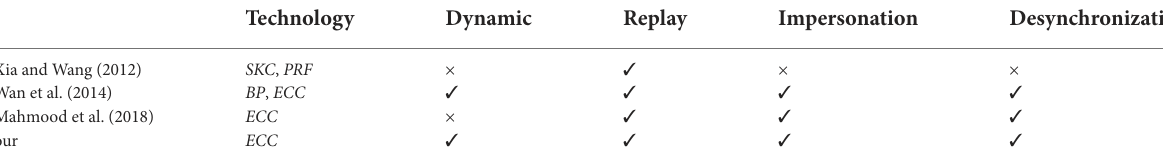
TABLE 1 Comparisonwithpreviousprotocols. Technology